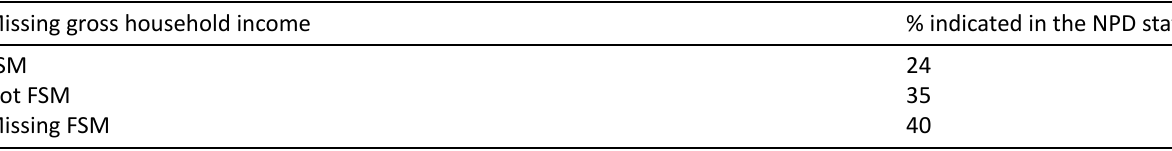
Table 4. Cases missing income and FSM data in linked dataset. Missing gross household income